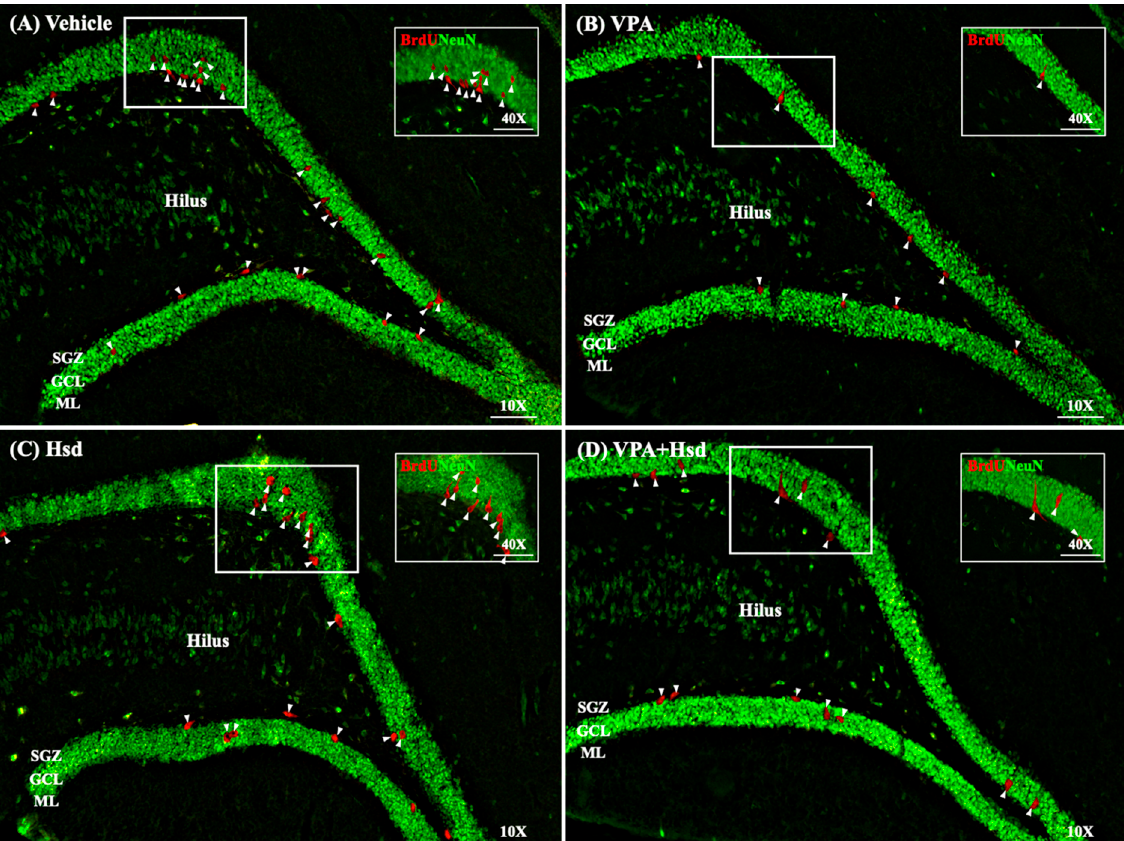
Figure 7. Illustrative images of the neuronal cell survival marker in the DG ( A – D ). For double staining of BrdU and NeuN, BrdU-positive cells stained red were found in the SGZ of the hippocampal DG, and anti-NeuN was used to counterstain all nuclei (green). Arrowheads indicate BrdU-positive cells in the DG (scale bars: 100 μ m). Inserted figures display high magnification of BrdU/NeuN immunostaining (scale bar: 50 μ m).